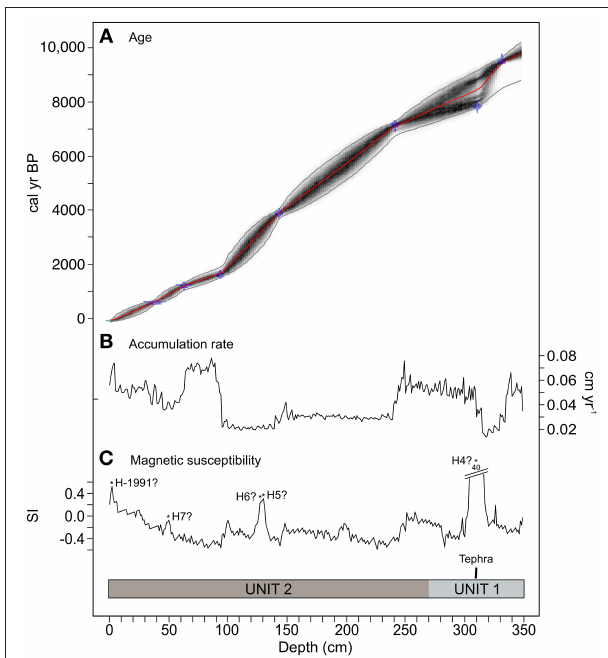
FIGURE 2 | (A) Age-depth model (The red curve shows the weighted mean age for each depth. Dark and light gray lines depict the more likely age-depth models and 95% confidence intervals, respectively. Blue areas represent the probability distributions of the calibrated dates), (B) sediment accumulation rates and (C) magnetic susceptibility for M. Casanova. Lithology and tephra –probably derived from eruptions of the Hudson volcano (H)- are shown. Depths are given in true core measurements, not the adjusted depths used in the development of the